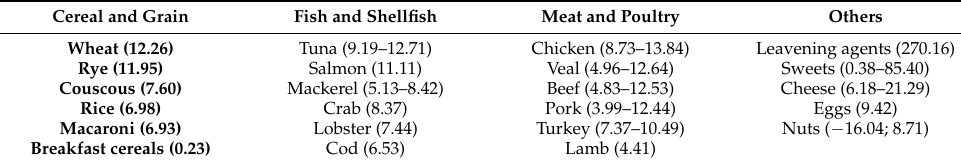
Table 1. Foods with high PRAL (PRAL in mEq per 100 g